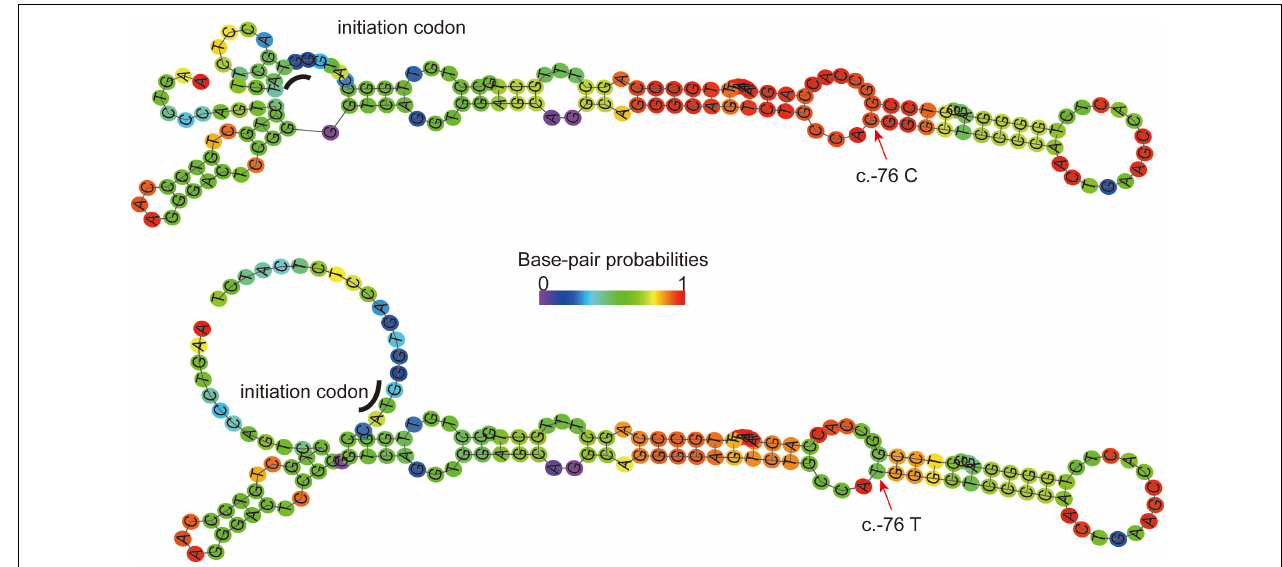
FIGURE 3 | RNAFold (http://rna.tbi.univie.ac.at//cgi-bin/RNAWebSuite/RNAfold) predicts the secondary structure of ABCG mRNA fragments ( − 140 to + 17) in normal wild-type (Top) and C. − 76C > T mutations (Bottom) . Arrow, mutation site; Underline, translation initiation codon; Ruler color, possibility of matching. The c. − 76C > T mutation significantly weakens the matching possibility of the stem-loop structure, leading to the apparent loosening of the RNA at the initiation codon, which frees the initiation codon and improves the translation efficiency. This is similar to the translation regulation mode of